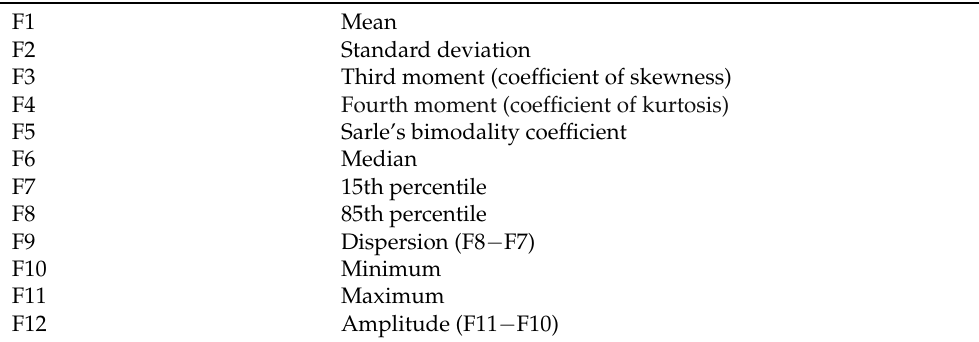
Table 3. Twelve statistics of speed profiles calculated for each distance interval for the func- tional method.